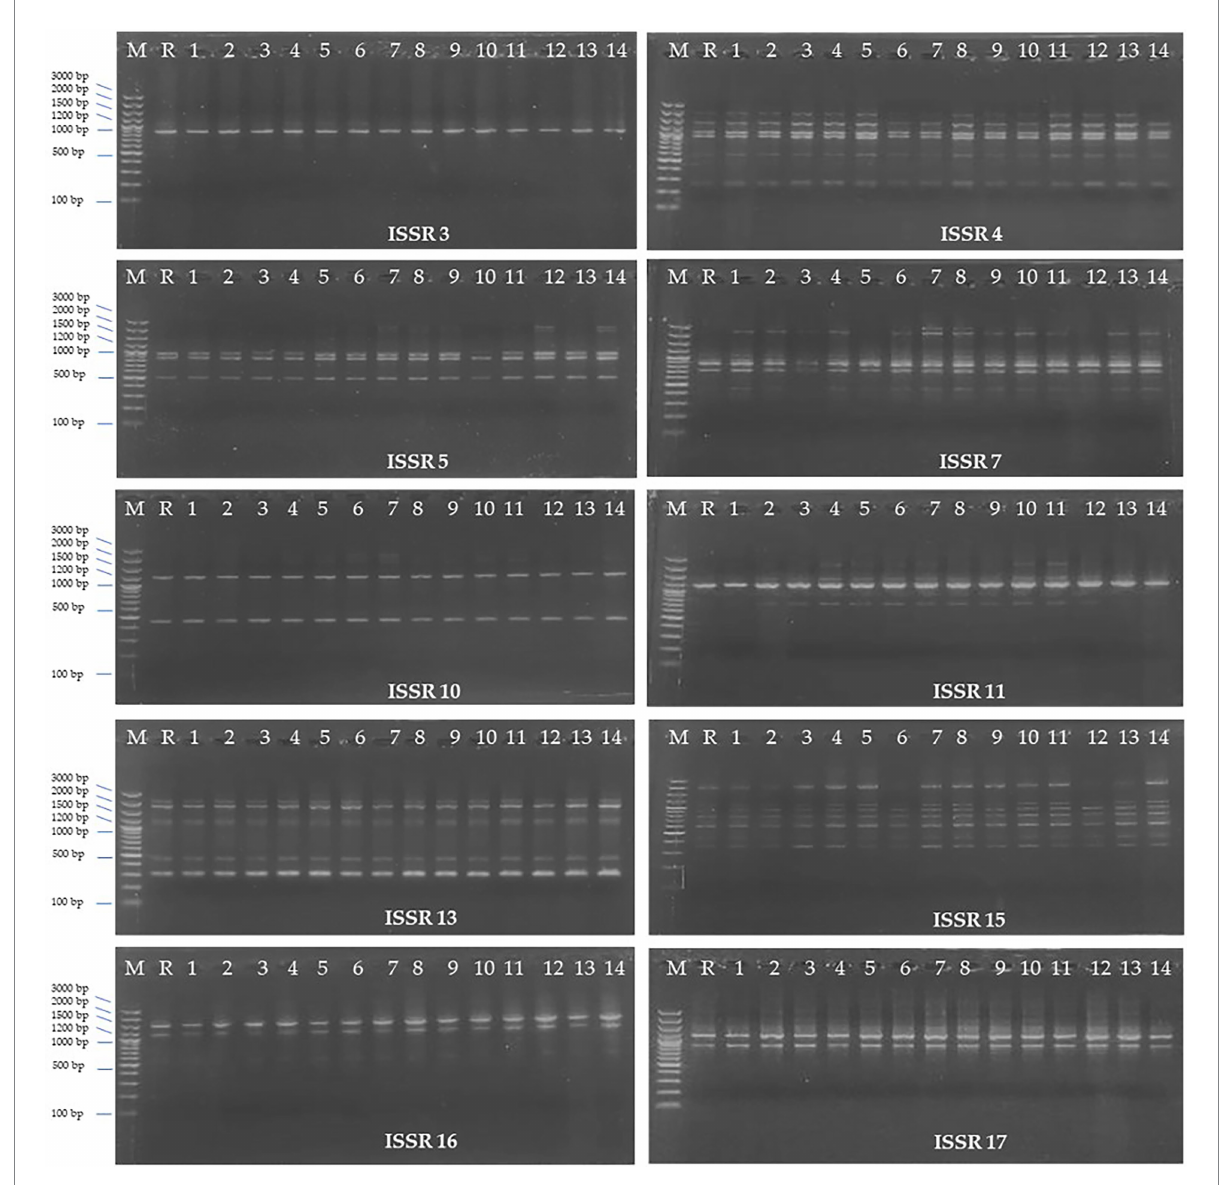
FIGURE 7 ISSR (Inter Simple Sequence Repeat) profiles of 10 ISSR primers; Lane 1: Ladder, Lane 2: Reference plant, Lane 3–14: regenerated H. tuberculatum